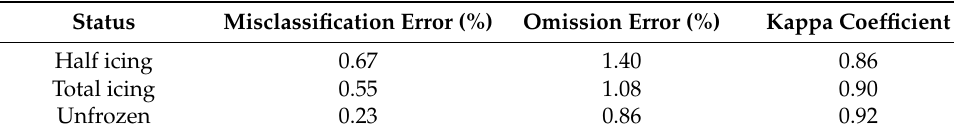
Table 4. Evaluation of the accuracy of the glacial lake in different states.